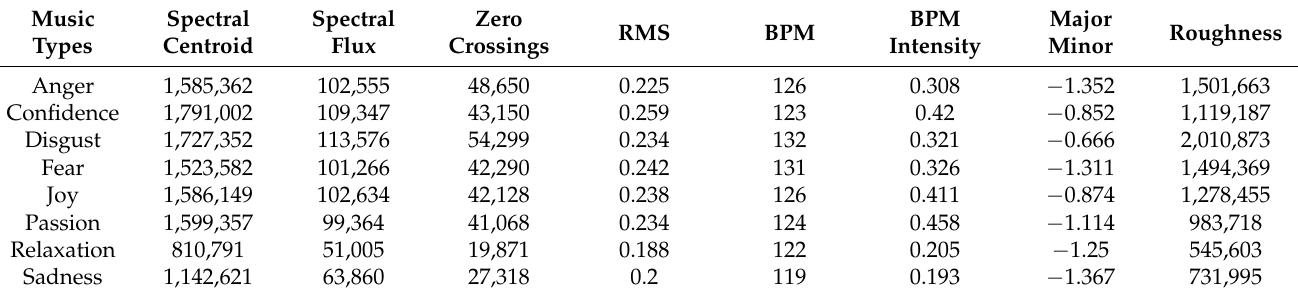
Table 6. Extraction audio features statistics.